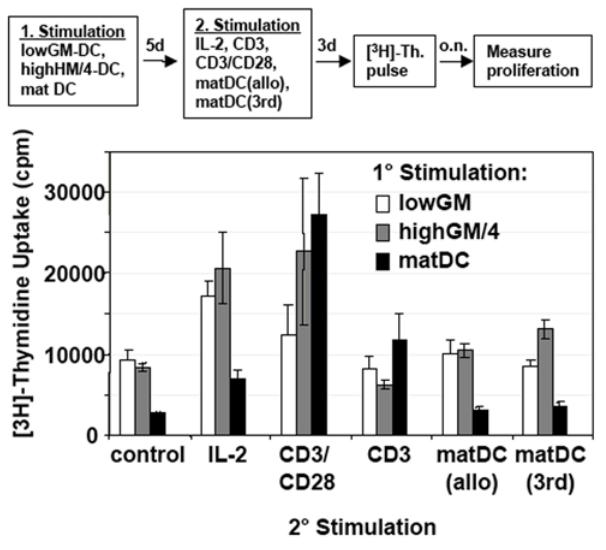
Figure 3. A single allogeneic T cell priming by lowGM-DC does not induce T cell anergy. Allogeneic T cells were stimulated with either immature lowGM-DC or immature highGM + IL-4-DC or LPS- matured highGM + IL-4-DC. After 5 days the T cells were restimulated with IL-2 or the indicated antibodies or LPS-matured DC from the original allotype (matDC allo) or a third party allotype (matDC 3rd) or cells were left without stimulation (control) for another 3 days before [ 3 H]-thymidine ([ 3 H]-Th.) was added overnight to measure proliferation as shown in the flow chart. The data from one experiment shown are representative of 5 independent experiments. Values represent the mean 6 standard deviation error bars of triplicate cultures from one